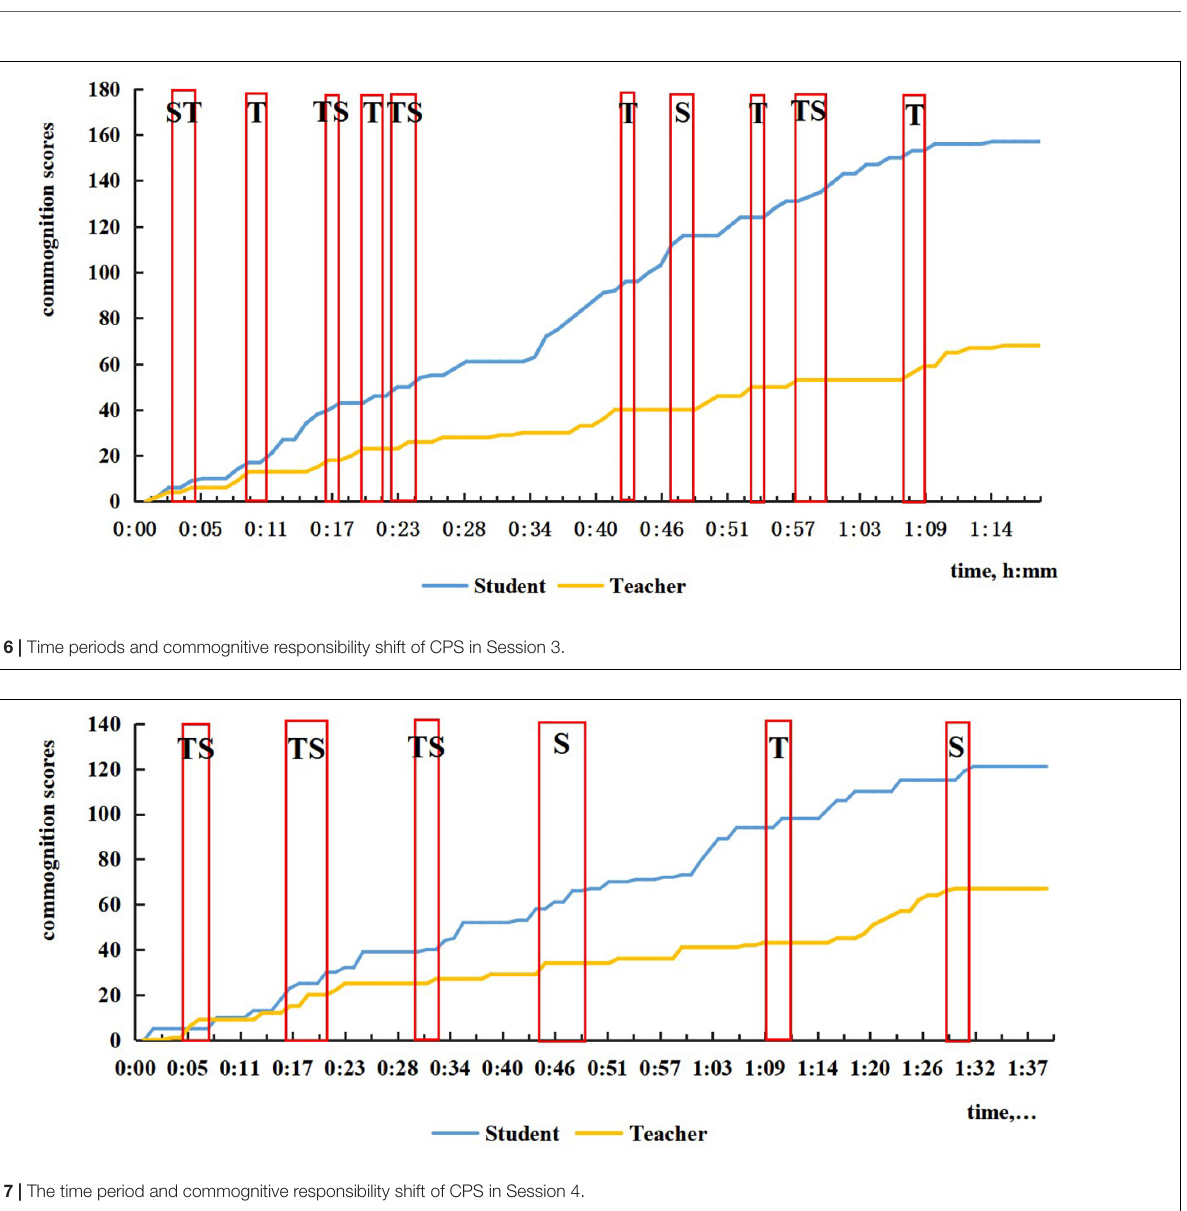
FIGURE 7 | The time period and commognitive responsibility shift of CPS in Session